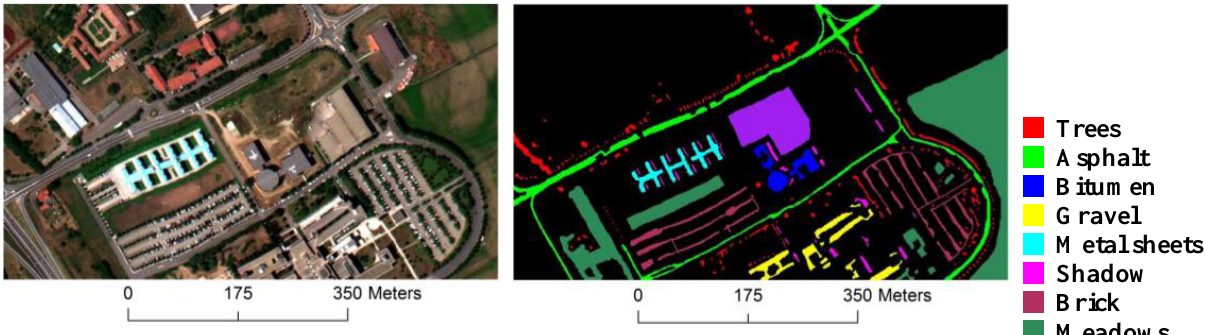
Figure 5. The Pavia University image and its reference